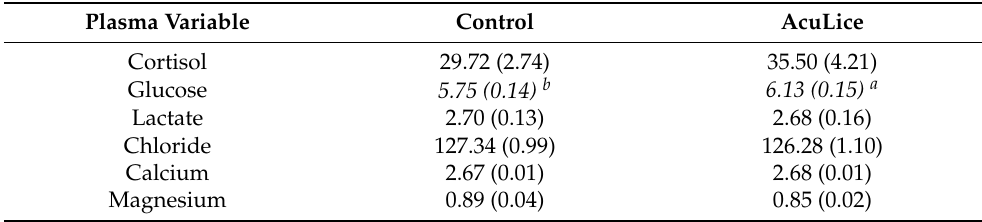
Table 2. Average plasma concentrations (mmol L − 1 ) of cortisol, glucose, lactate, chloride, calcium, and magnesium for Atlantic salmon before starting the AcuLice treatment (control) and 1 h after starting the AcuLice device (AcuLice). Each data sample is presented as a mean ± SEM, N = 30. Different letters and italics indicate significant statistical differences (two-way nested ANVOA, p < 0.05) between the experimental groups.